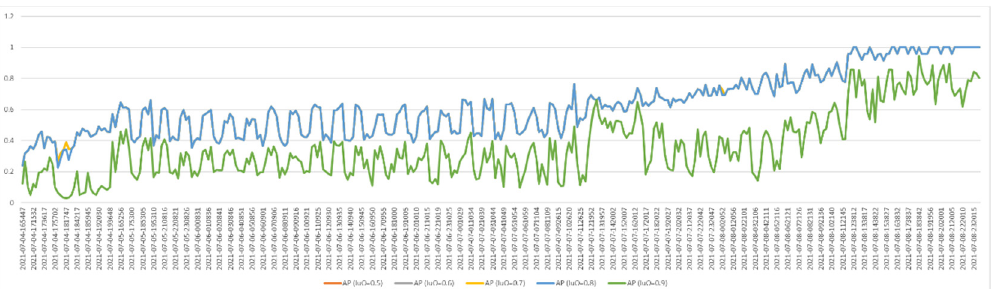
Figure 10. AP values for the second test dataset (IoU: 0.5–0.9).